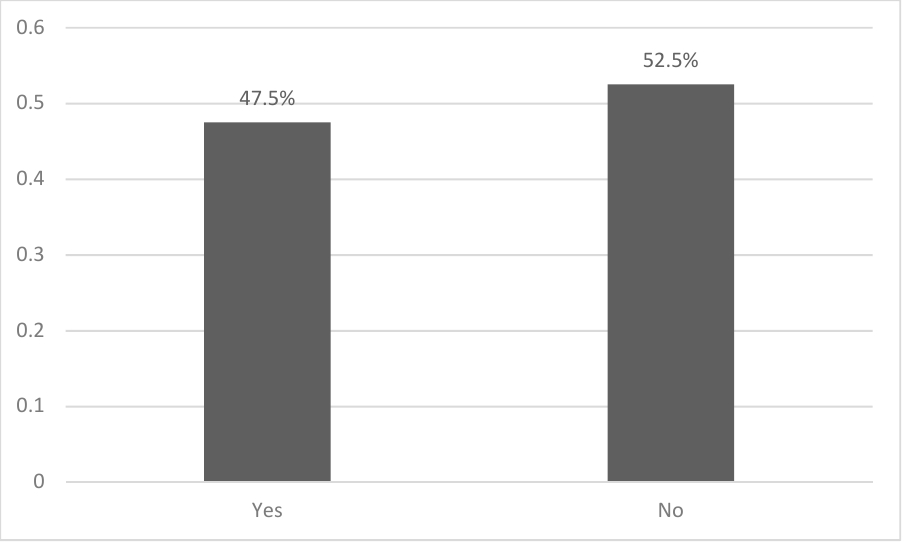
Figure 2. Survey responses to “Have you heard of Socially Responsible Investment?” question. Source: own